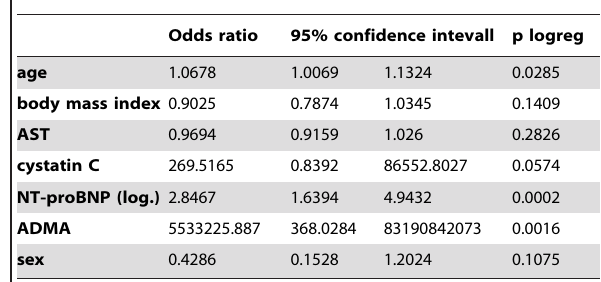
Table 5. Results of univariate logistic regression analysis for different parameters regarding their ability to identify patients with severely limited cardiopulmonary exercise